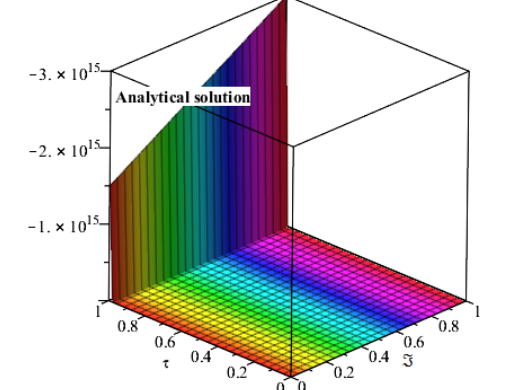
Figure 16. Represents the analytical solution of Example 5 at β = 1.